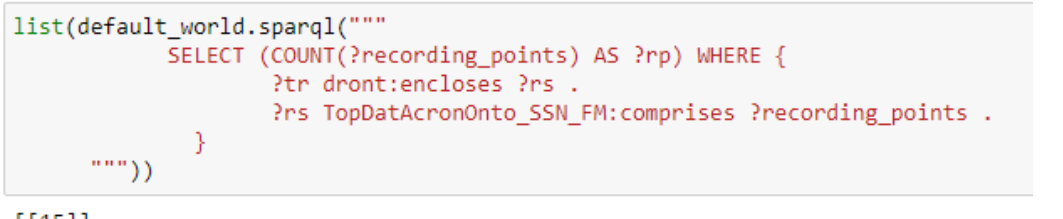
Figure 16. An example SPARQL query defined by user in Jupyter notebook environment.